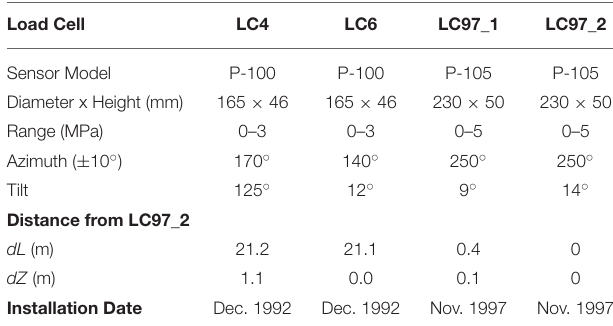
TABLE 1 | Characteristics of the load